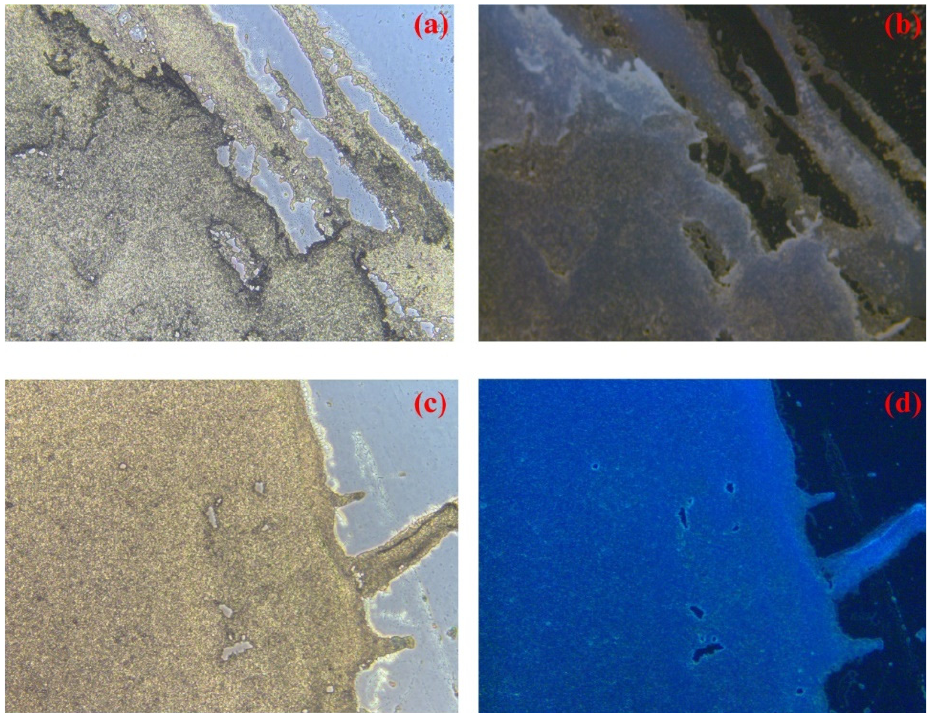
Figure 6. The fluorescence images of Saccharomyces cerevisiae under a Leica fluorescence microscope; the cells grown in the medium without the C-CDs in normal vision ( a ) and UV light vision ( b ); the cells grown in the medium with 75 μ L·mL − 1 of C-CDs in normal vision ( c ) and UV light vision ( d ).